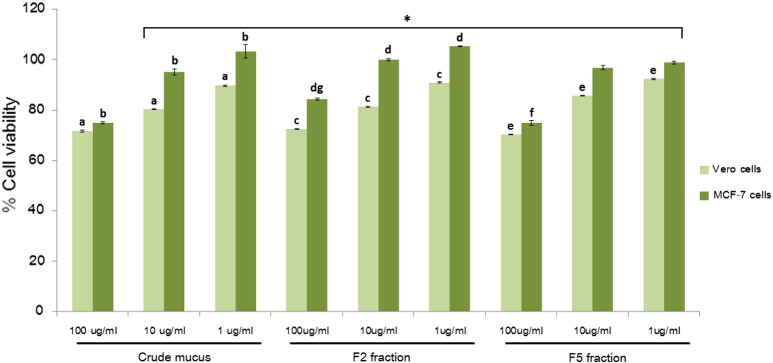
Percentages of the Vero and MCF-7 cell viabilities after treatment with A. fulica crude mucus and the F2 and F5 fractions at the concentration of 1, 10 and 100 μg/ml. The cell viability was measured by the MTT assay. Control was the untreated cells. Error bars represented the SD, * represented statistical difference between the viability of Vero and MCF-7 cells at the significance of p < 0.05. a, b, c, d, e and f: significant difference between concentrations of the crude mucus (a and b), the F2 (c and d) and F5 (e and f) fractions, respectively, p < 0.05. g represented the significant difference (p < 0.05) of the F2 fraction from the crude mucus and the F5 fraction at 100 μg/ml.